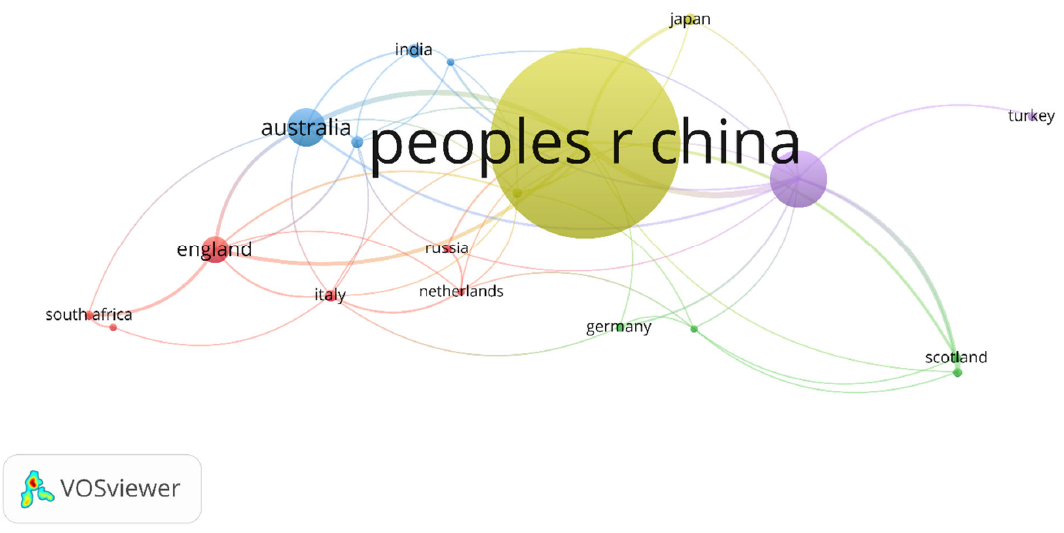
Figure 9. Network visualization of international collaboration.